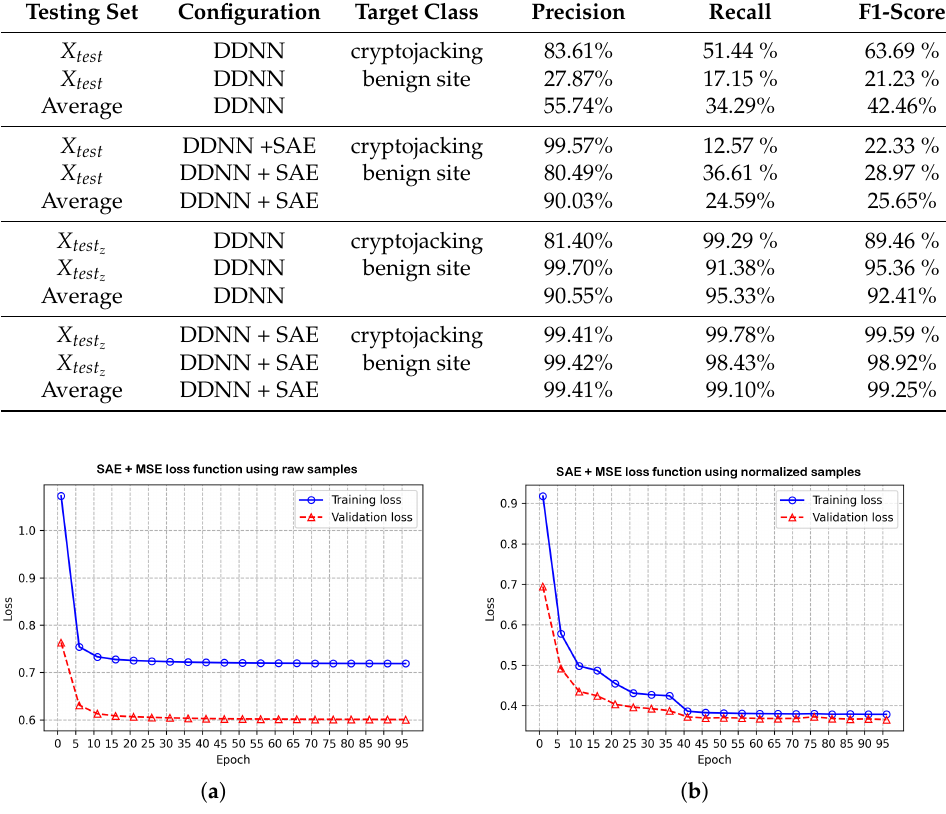
Figure 8. Comparison of loss function curves using MSE, in contrast to raw and normalized samples, subject to SAE